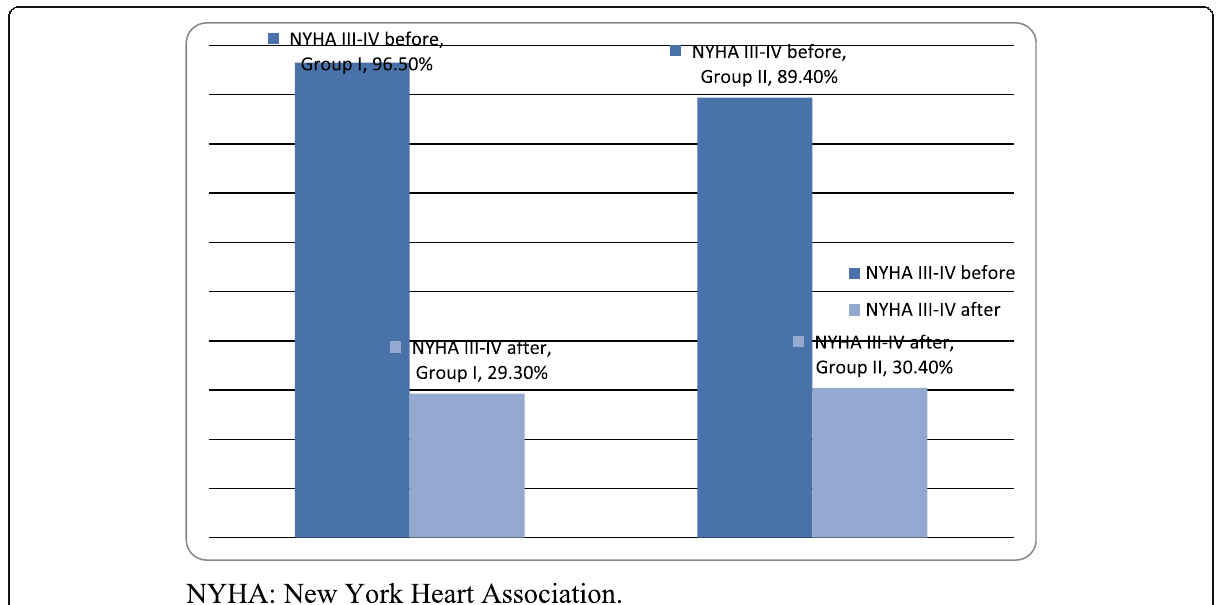
Fig. 3 NYHA classification before and after mitral clip procedure. NYHA, New York Heart Association